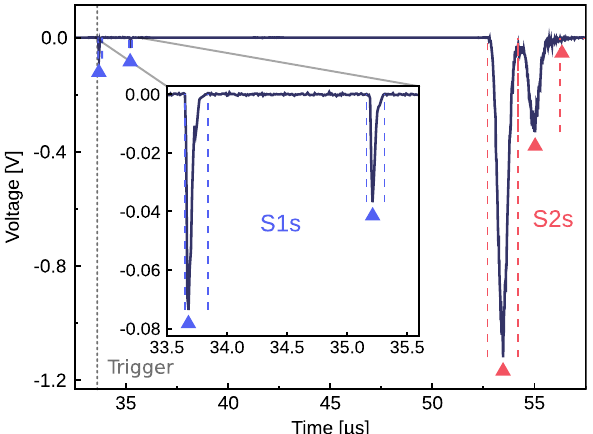
Fig. 9 Time difference between the scintillation pulses (S1s) originat- ing from the decays of 83m Kr at 32.1keV and 9.4keV between the 0.1 and 0.5 area quantiles, is below 200ns and the pulse width (time duration between 0.1 and 0.9 area quan- tiles) to be smaller than 500ns. Peaks which do not satisfy these criteria are classified as S2 pulses. The 0.5 area quan- tile is taken as the peak’s time relative to the beginning of the event in which it is found. The efficiency of this criterion for S1 pulses from alpha interactions is evaluated to be > 99 . 9% using the pulse-shape parameters measured in